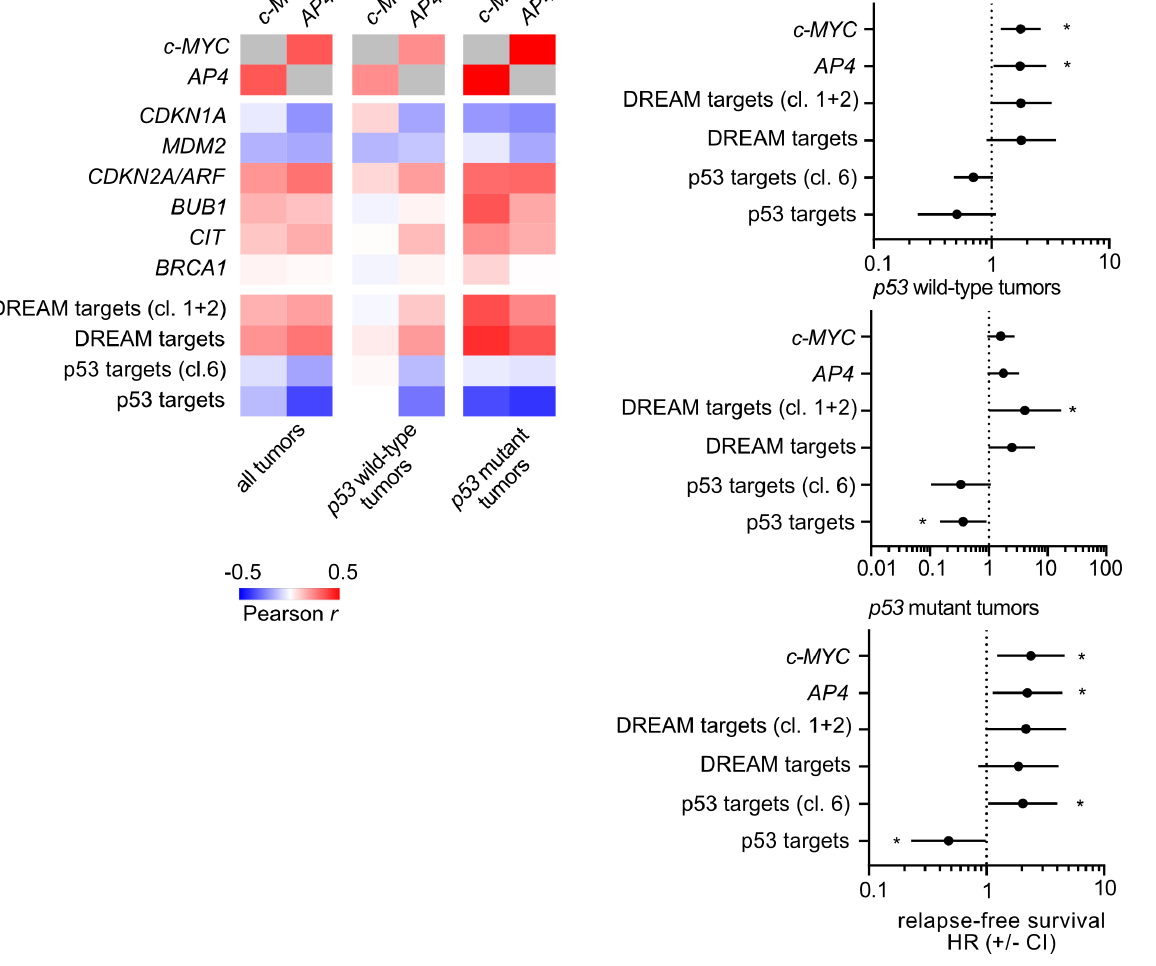
Figure 10. Conservation of c-MYC/AP4/p53/p21/DREAM targets correlation and clinico-pathological associations in primary breast cancer. ( A ) Expression correlations (Pearson r ) of c-MYC and AP4 with p21/CDKN1A , DREAM target and p53 target gene signatures were analyzed using public expression data (TCGA-BRCA). ( B ) Association analysis of the indicated factors and gene signatures with patient survival with regard to p53 status using public expression data (TCGA-BRCA). Asterisks indicate statistically significant associations ( p < 0.05).